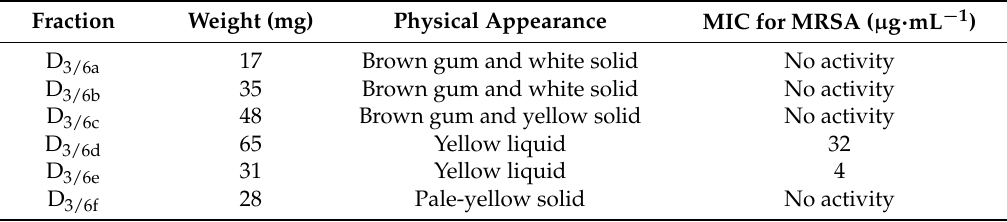
Table 3. ASDE subfractions of D 3/6 and their respective MICs against MRSA ATCC 43300.